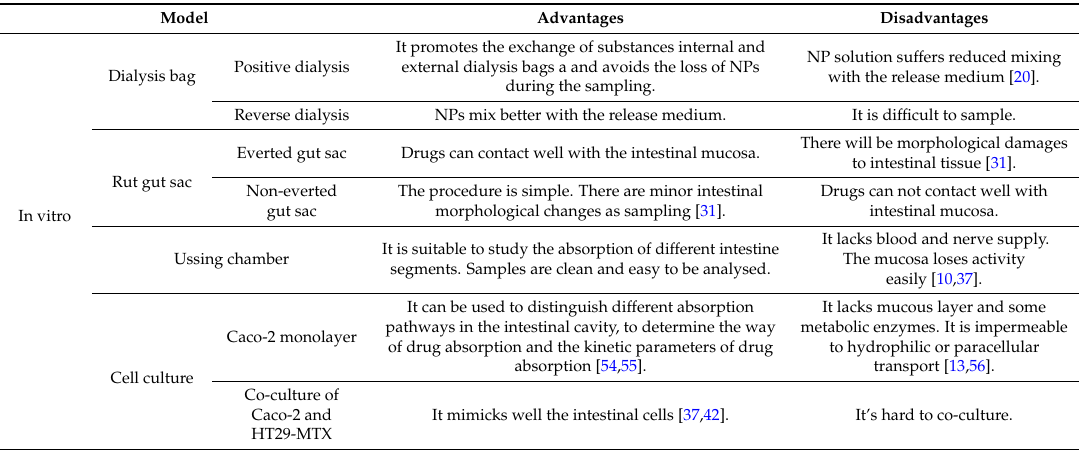
Table 1. Advantages and disadvantages of the different intestinal absorption